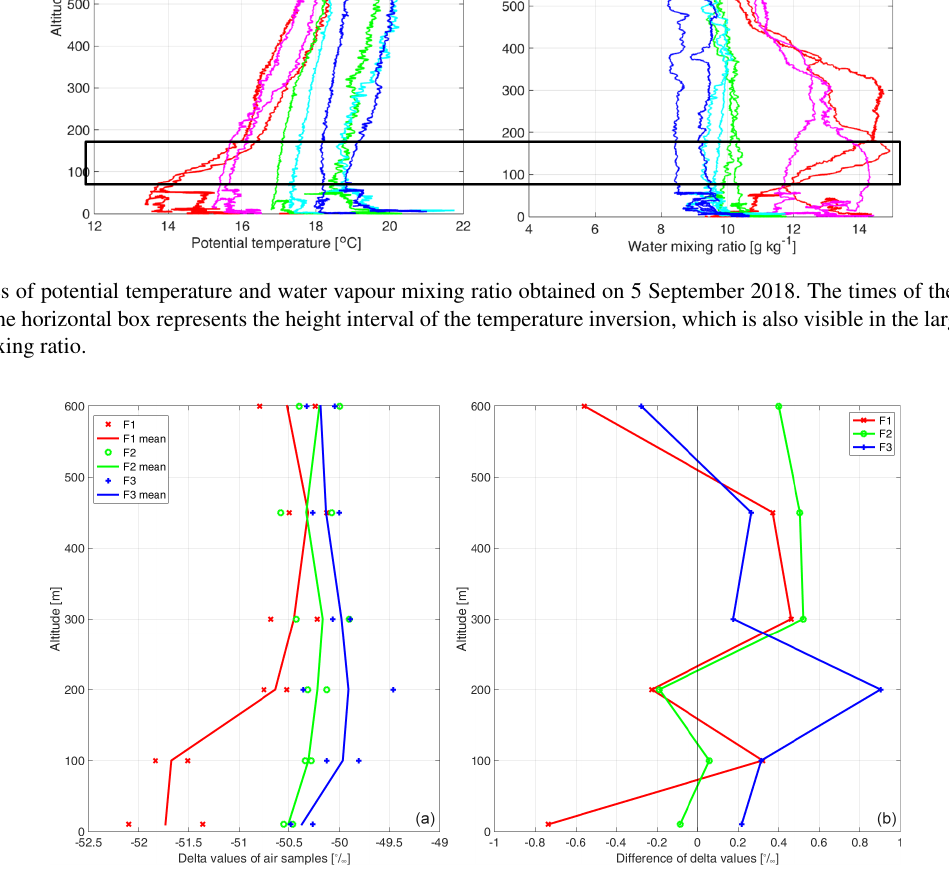
Figure 9. Profiles of (a) δ 13 C values for all air samples during the flights on 23 May 2018, and (b) difference of delta values between the double samples filled simultaneously at the same